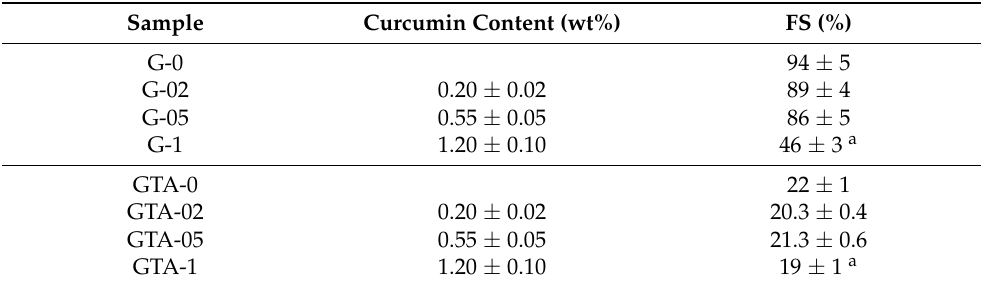
Figure 3. Absorption spectra of film solutions in water/ethanol 1:1. Curcumin content determined from evaluation of the absorption spectra (Table 1) increases with its concentration in solution up to about 1.2 wt%. Curcumin content in GTA samples was not measured since the films are not soluble after crosslinking. However, since GTA treatment was performed after curcumin adsorption, it is reasonable to assume the same values as those of G samples. Table 1. Curcumin content and water solubility of the functionalized films.